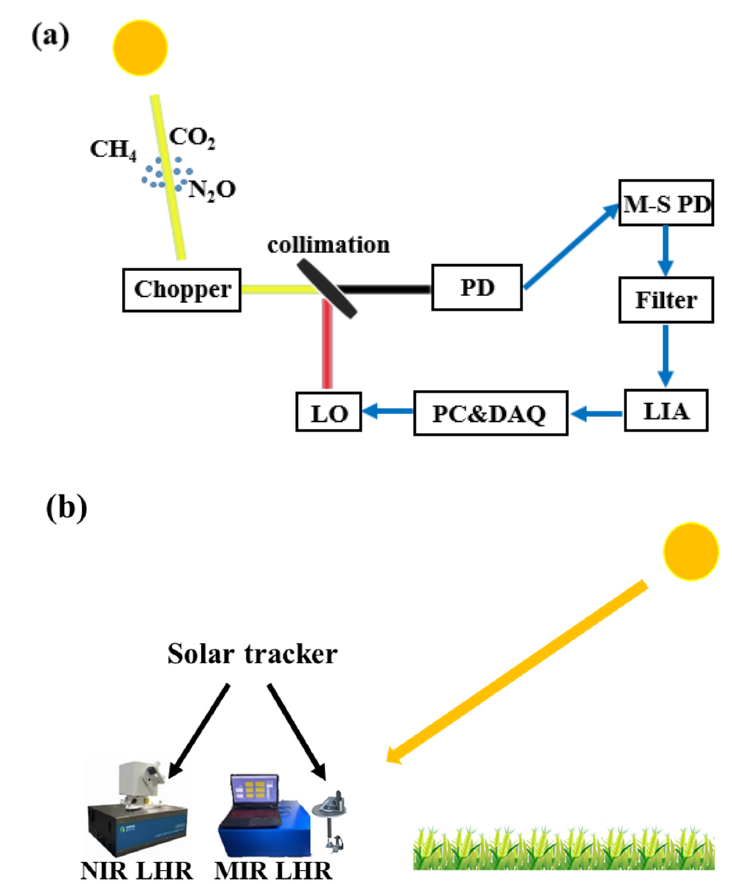
Figure 1. ( a ) Schematic diagram of LHR. LO: local oscillator, PD: photodetector, M-S PD: mean-square photodetector, LIA: lock-in amplifier, DAQ: data acquisition, PC: personal computer; ( b ) photo of the near-infrared laser heterodyne radiometer (NIR LHR) and mid-infrared laser heterodyne radiometer (MIR LHR).